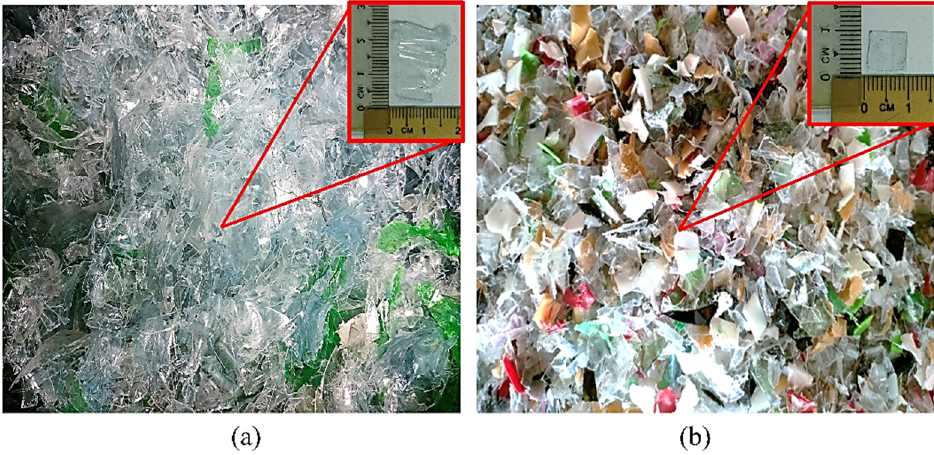
Figure 15. Shredded PET plastic grain with ( a ) long strands and ( b ) PET plastic grain after screen/mesh .